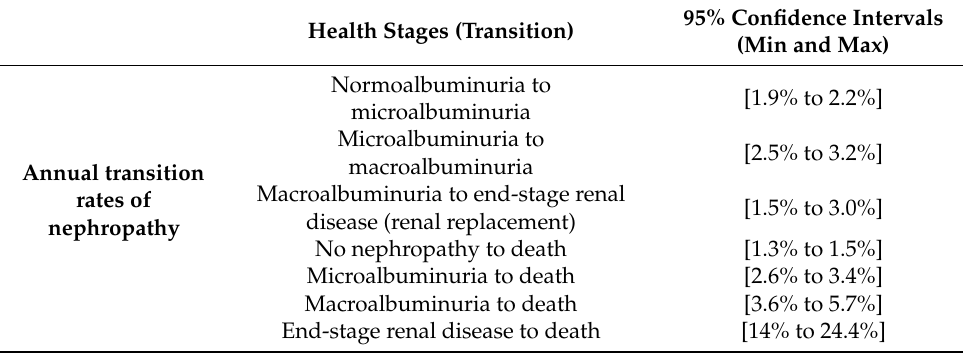
Table 2. Transition